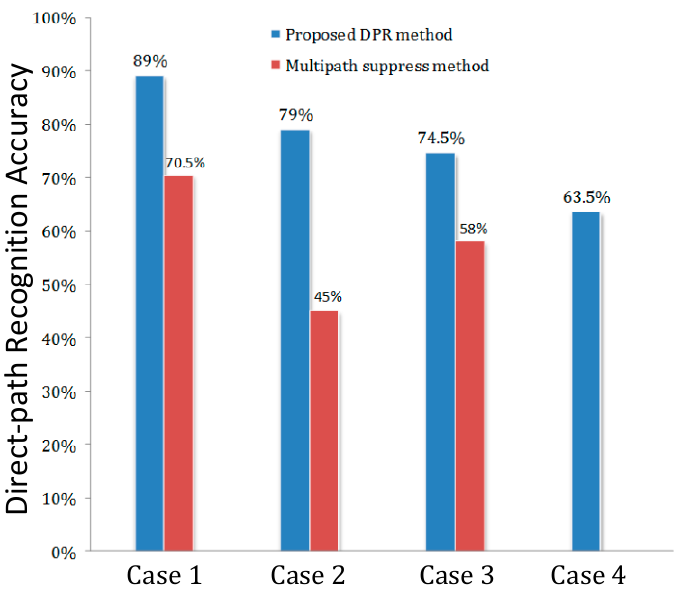
Figure 9. Direct-path recognition accuracy results from Monte Carlo simulations.